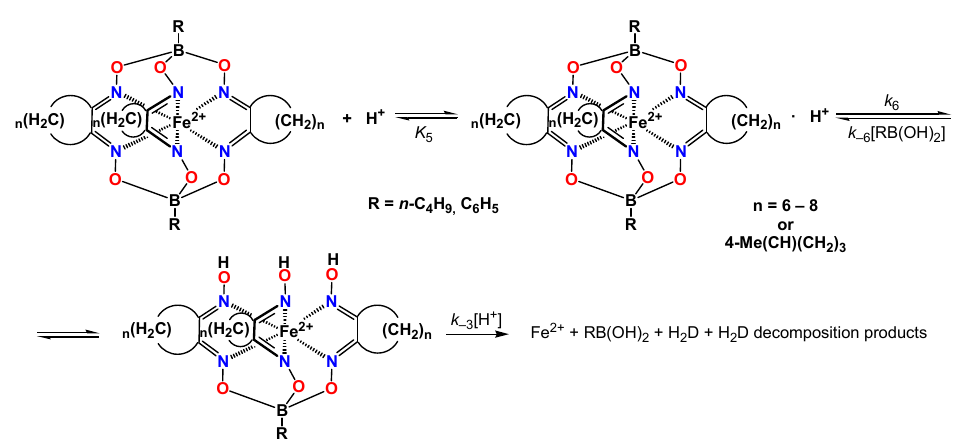
(15) An example of the determination of this constant is shown in Figure 12. The values of the decomposition reaction rate constants d eff k were obtained as the tangents of linear regressions plotted in the coordinates lnA versus time. Figure 12. Example of a determination of the decomposition reaction rate constant d eff k for the clathrochelate FeOx 3 (BCH 3 ) 2 ( 5 ) at its concentration 4.6 × 10 − 5 mol L − 1 in 2.6 M solution of sulfuric acid ( H a + = 0.019 mol L − 1 ). Decomposition of the n -butyl- and phenylboron-capped iron(II) alicyclic tris-dioxi- mates clathrochelates is known from literature [1,4,5,36] requiring their protonation (Scheme 4). The corresponding apical substituents cannot be protonated under these ex- perimental conditions and H + ions add to the ester oxygen atoms of the B–O–N chains of